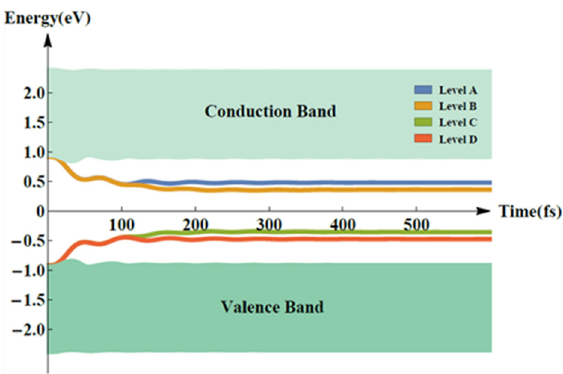
Figure 1. Evolution of the energy levels within 500 fs under pumping by an external laser of 70 µ J / cm 2 .